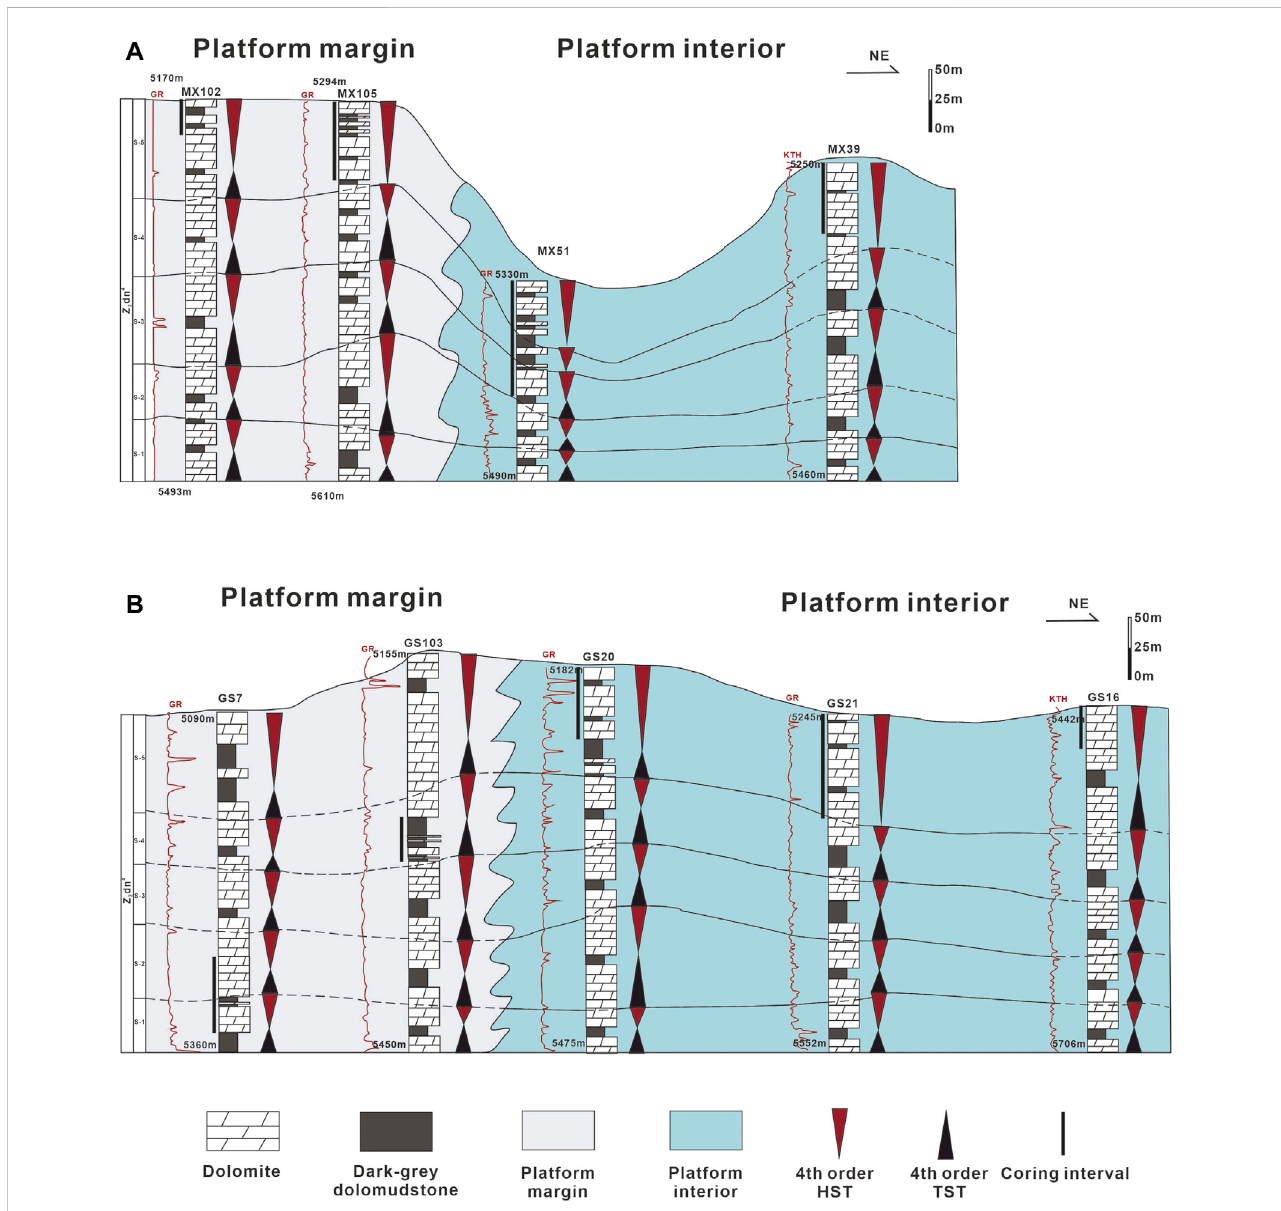
FIGURE 4 Fourth-order sequence stratigraphic classi fi cation of the Z 2 dn 4 of the Gaoshiti — Moxi area. (A) Fourth-order sequence stratigraphic class fi cation of the Moxi area. (B) Fourth-order sequence stratigraphic classi fi cation of the Gaoshiti area.